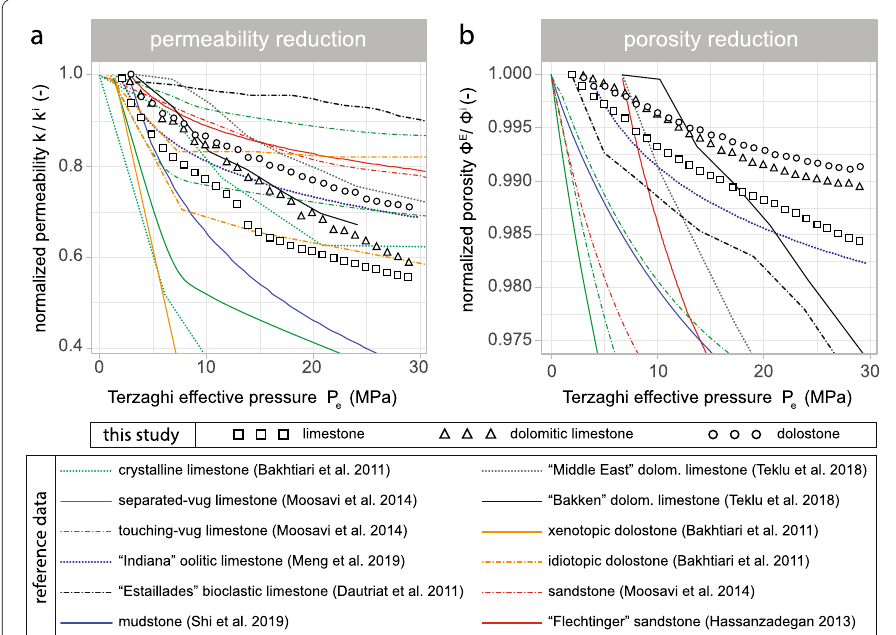
Fig. 13 Normalized stress sensitivity for different lithology and facies types. a Average permeability reduction of the tested Malm samples fits well within the range of reference data reported by various authors. The lower limit is defined by rock types with a well-connected flow network, while the upper limit is represented by rock types with a poorly developed flow-network dominated by compliant micro-cracks and elongated pores. b Results for the stress-induced porosity reduction show a discrepancy with most data from the literature and are relatively low for the Malm carbonates. Differences in the test procedure can have